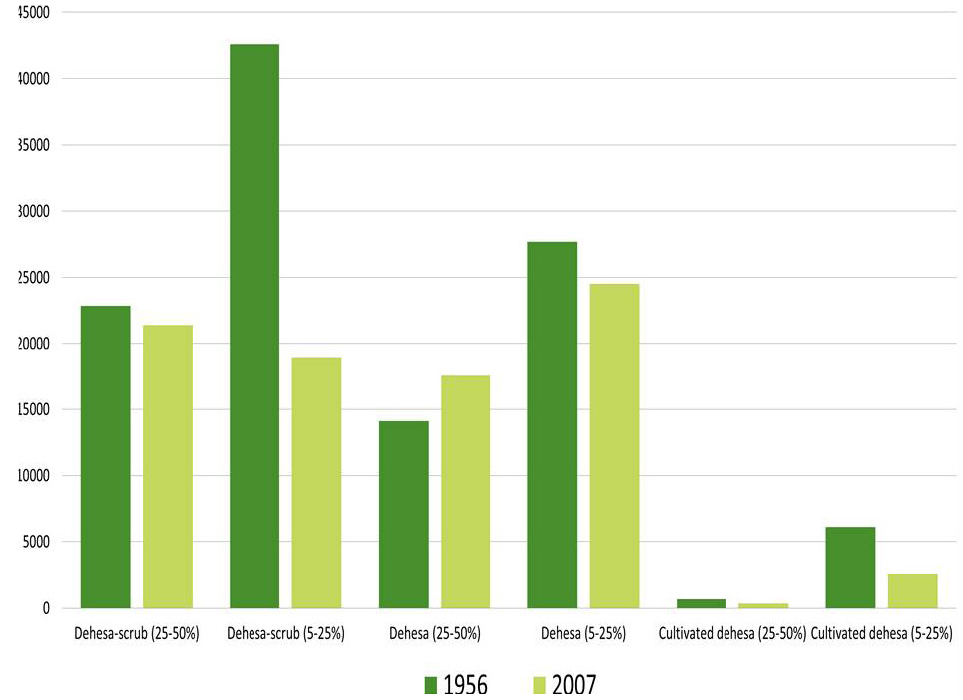
Figure 4: Changes in the types of dehesa. Hectares. Source: Geodatabase created by the author